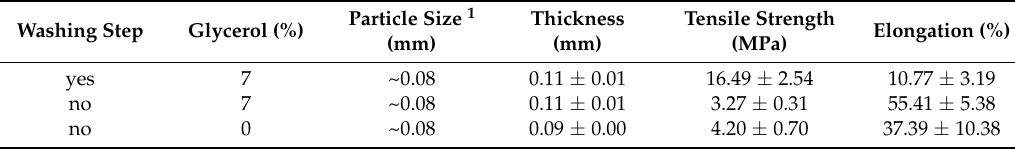
Table 2. Different preparation conditions and main properties of bio-based films prepared from apple pomace, using 1% (w/v) citric acid solution at 70 ◦